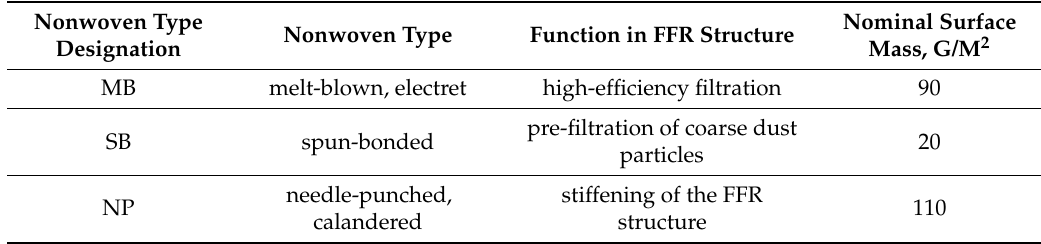
Table 1. Characteristics of filtering